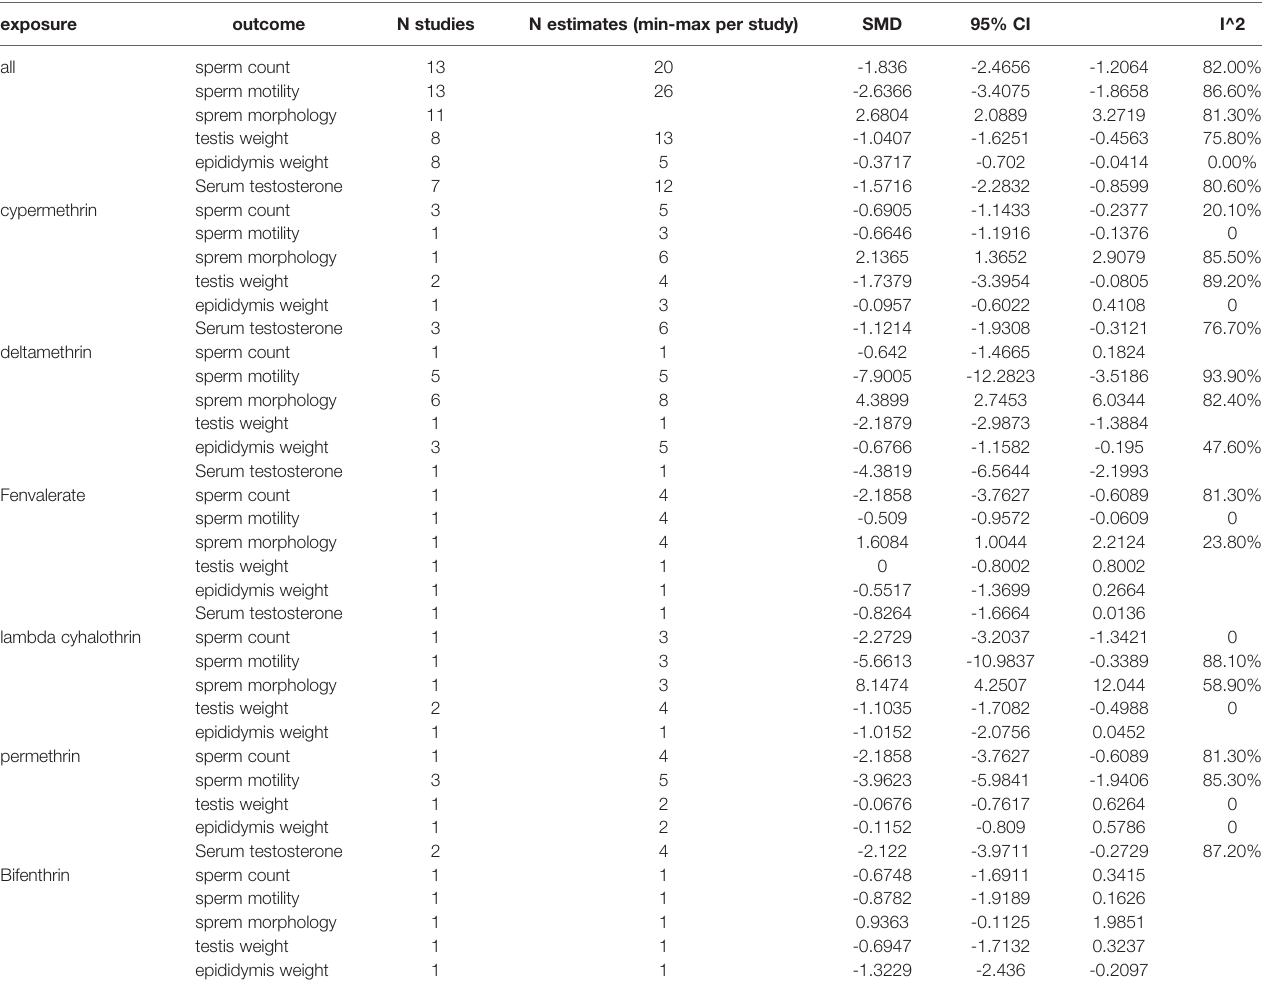
TABLE 2 | The effect of pyrethroid exposure on